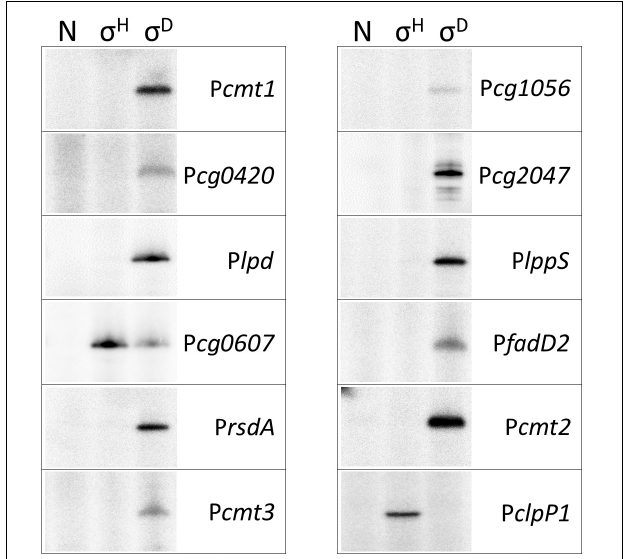
FIGURE 2 | In vitro transcription driven from σ D -dependent promoters with reconstituted C. glutamicum holo-RNAPs (autoradiogram of the SDS-PAGE gel). The lanes with no sigma (N), σ H and σ D are shown. In vitro transcription was carried out as described previously (Holátko et al., 2012). The derivatives of the plasmid vector pRLG770 with inserted promoter fragments (approximately 75 nt) were used as DNA templates, recombinant RNAP core was isolated from C. glutamicum , and sigma factors were isolated as His-tagged proteins from E. coli using the pET-22b(+) constructs carrying the respective inserted sig genes (Holátko et al., 2012; Šilar et al., 2016). The σ H -specific promoter P clpP1 was used as a control. Representative results of 2–3 assays are